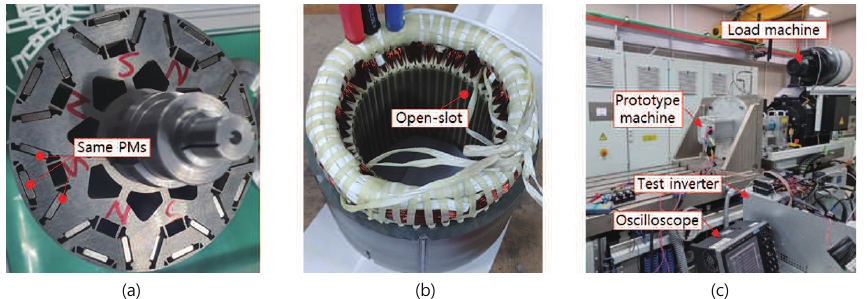
Figure 10. Prototype machine and experiment environment: ( a ) delta-IPM rotor, ( b ) uniform slot stator with a stranded winding, and ( c ) dynamometer test environment.